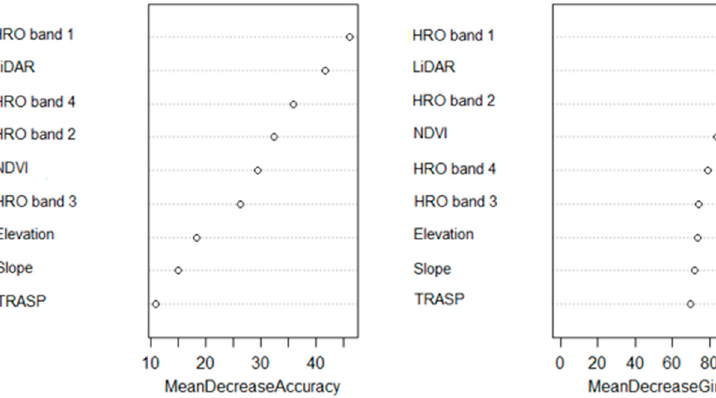
Table 4. Matrix of fire behavior fuel model (FBFM) class distribution by National Fire Danger Rating System (NFDRS) slope steepness classes at Army Garrison Camp